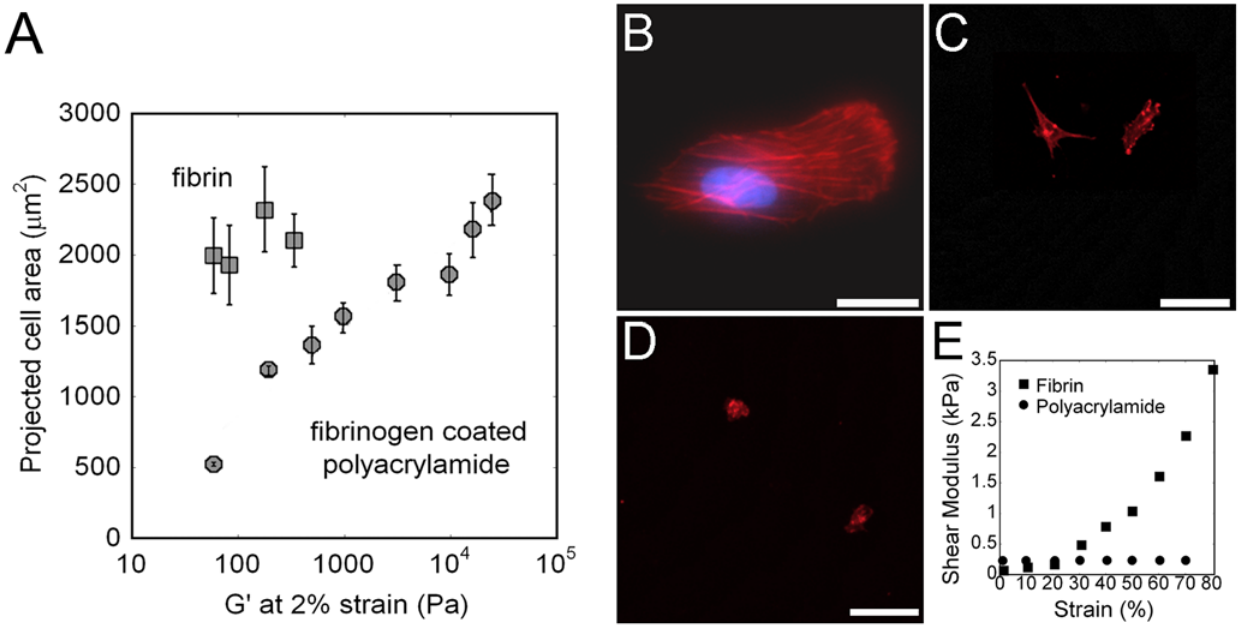
N Figure 1. Spread area of cells on fibrin is independent of the gel’s low strain modulus. A) Fibroblast’s spread area on fibrin ( & ) or ) gels of varying stiffnesses after 18 hours on substrate. Reported as mean 6 SE, n=3, at least 50 cells per group. fibrinogen coated polyacrylamide ( Fluorescence image of actin (red) structures of fibroblasts on 2 mg/ml fibrin Scale bar=20 m m, Nucleus in blue.(B), 10 kPa fibrinogen coated N polyacrylamide Scale bar=100 m m (C) and 0.1 kPa fibrinogen coated polyacrylamide Scale bar=100 m m (D). E) Strain versus shear modulus, ). measured by oscillating rheology, of 2 mg/ml fibrin ( & ) or 7% acrylamide, 0.05% bisacrylamide gels ( doi:10.1371/journal.pone.0006382.g001 PLoS ONE |